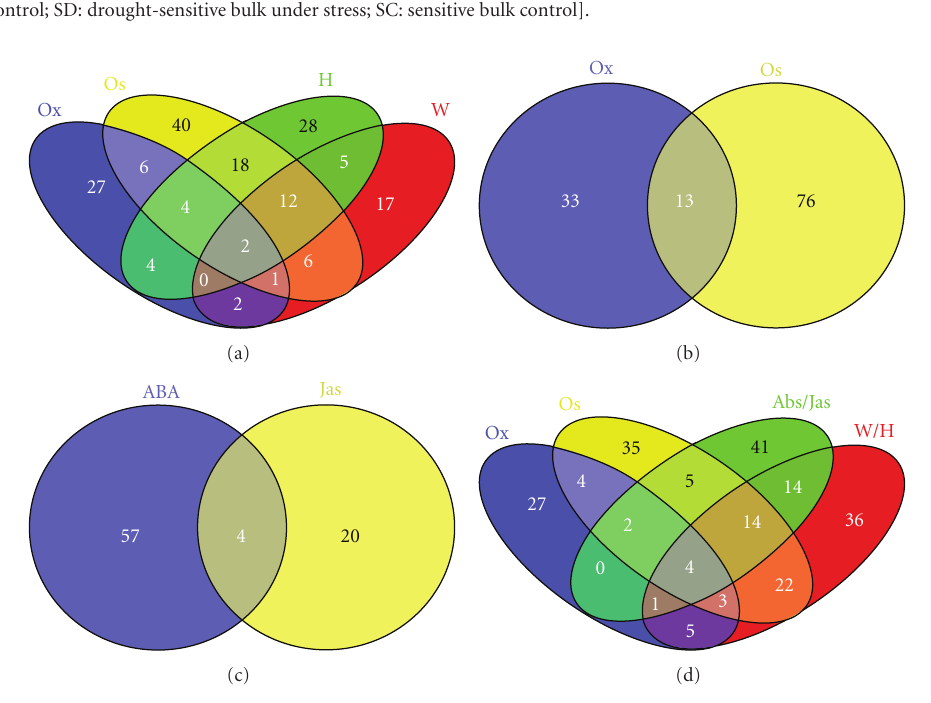
Figure 2: Venn diagrams with numbers of SuperSAGE tags overexpressed ( P ≤ 0 . 05) in sugarcane roots under drought stress, considering di ff erent tag sets related to gene ontology (GO) subcategories associated in response to: W (water deprivation), H (heat/cold), Os (osmotic stress), Ox (oxidative stress), ABA (abscisic acid stimulus), Jas (jasmonic acid